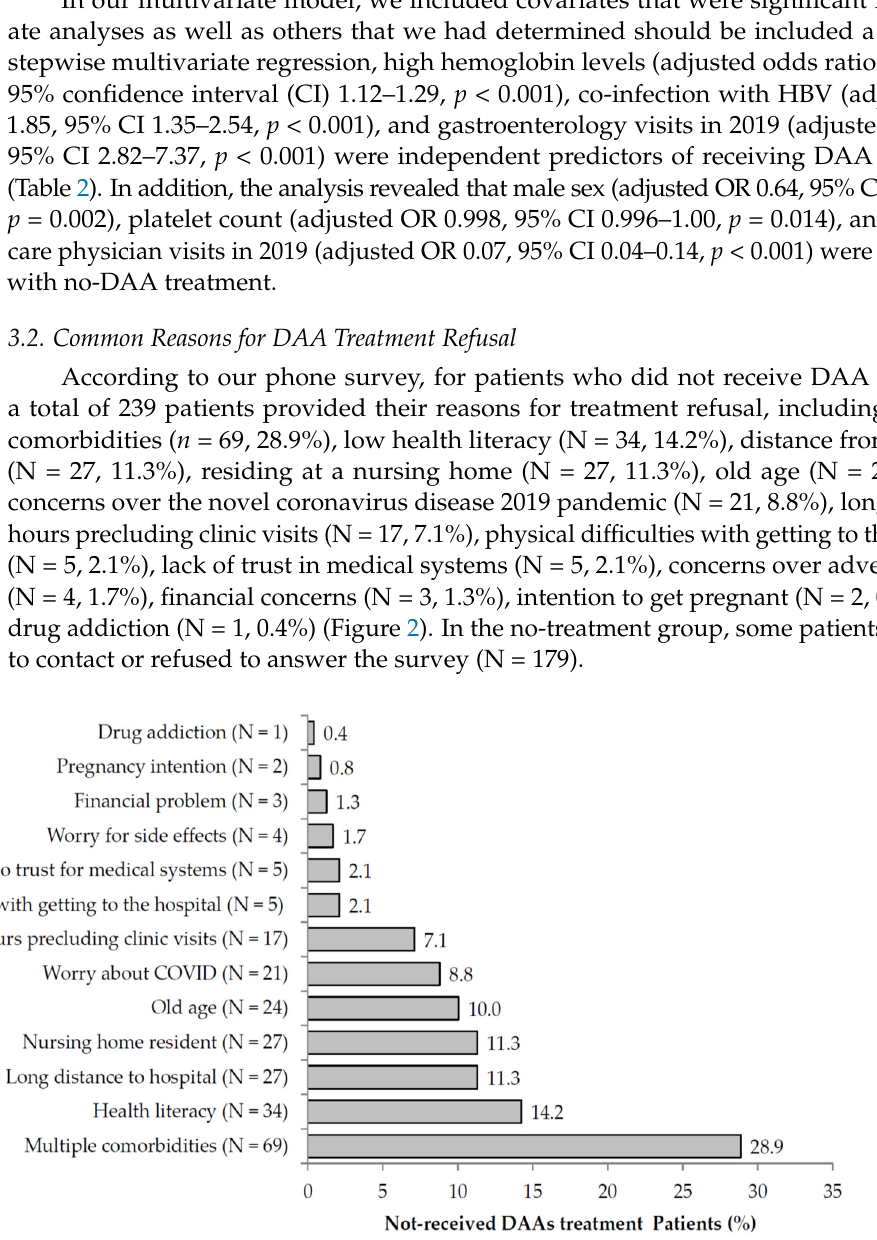
Figure 2. Implicit review findings: reasons for the lack of clinical follow-up on hepatitis C infection.